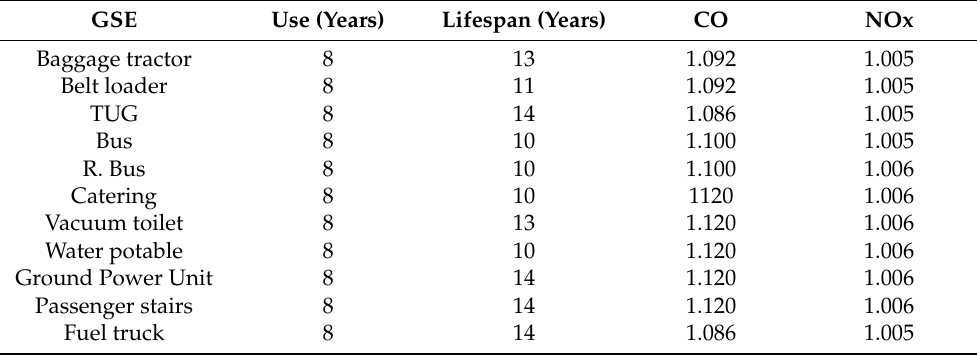
Table A5. Service years and lifetime per GSE type of vehicle for the damages factor. Service times. GSE Use